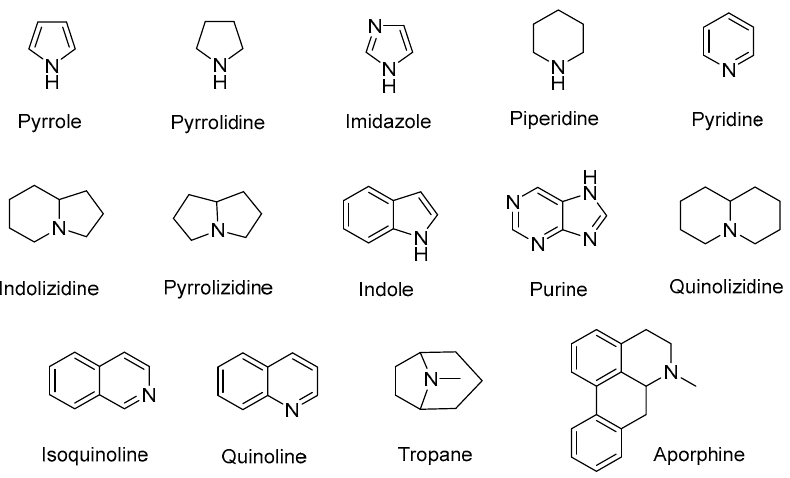
Figure 4. The 14 subgroups of alkaloids.